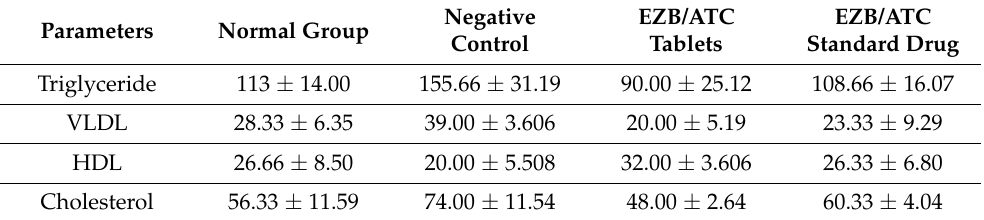
Table 4. Effect of atorvastatin and ezetimibe on lipid profile of rats in preventive study.